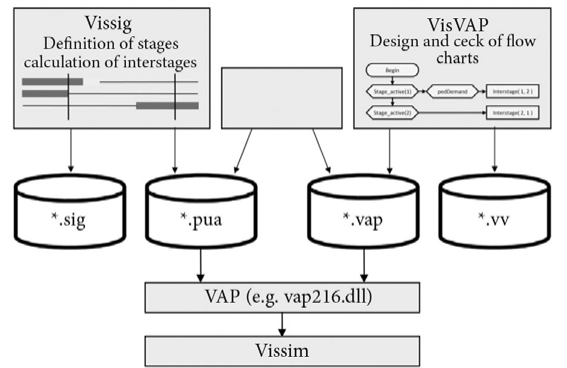
Fig. 5. Architecture of working files